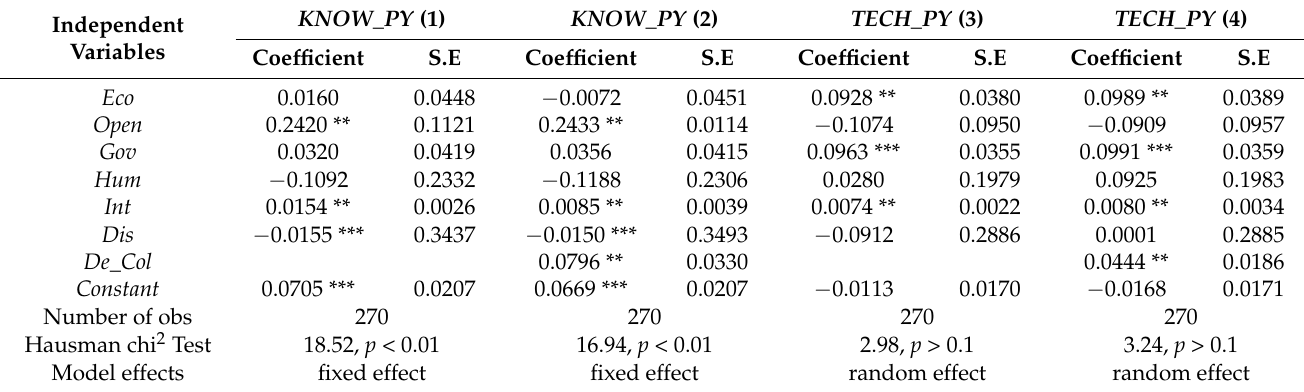
Table 2. Econometric results: the impact of De_Col on knowledge productivity and technology transfer productivity.